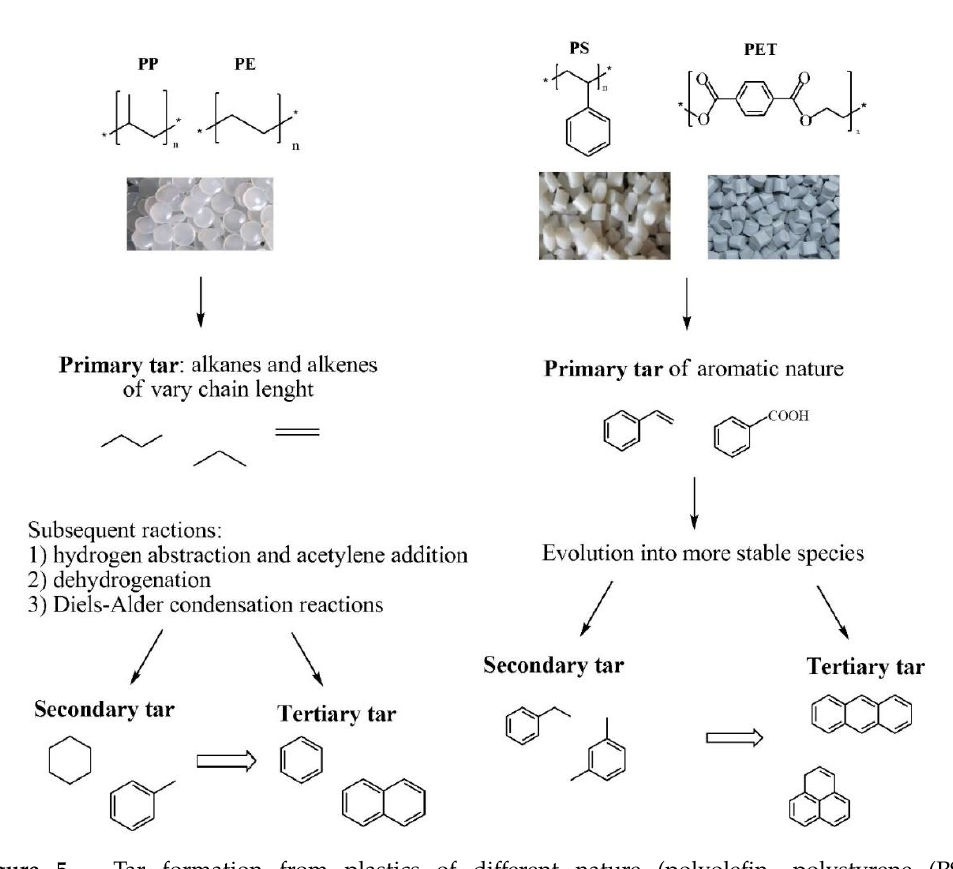
Figure 5. Tar formation from plastics of different nature (polyolefin, polystyrene (PS), polyethylene terephthalate (PET)) [20]. For each polymer we have represented only a small portion. With the symbol “*” we indicate that the chain continues.